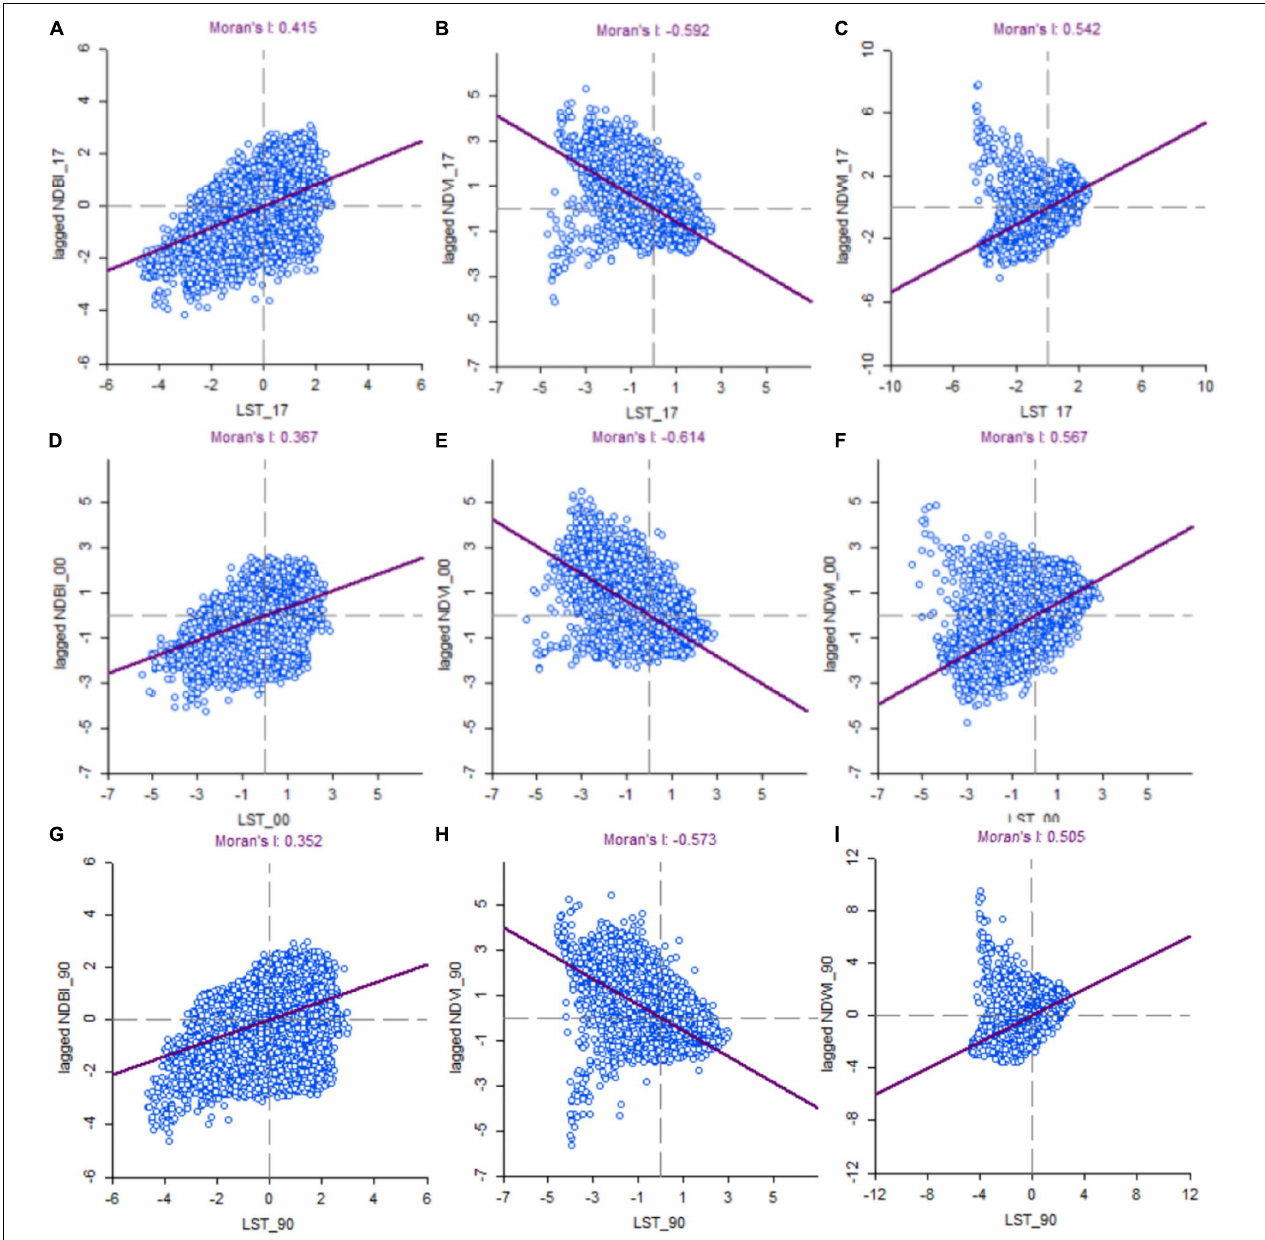
FIGURE 5 | Global bivariate Moran’ I spatial correlation between (A) LST-NDBI, (B) LST-NDVI, (C) LST-NDWI for 1990, (D) LST-NDBI, (E) LST-NDVI, (F) LST-NDWI for 2000, (G) LST-NDBI, (H) LST-NDVI, (I) LST-NDWI for the year